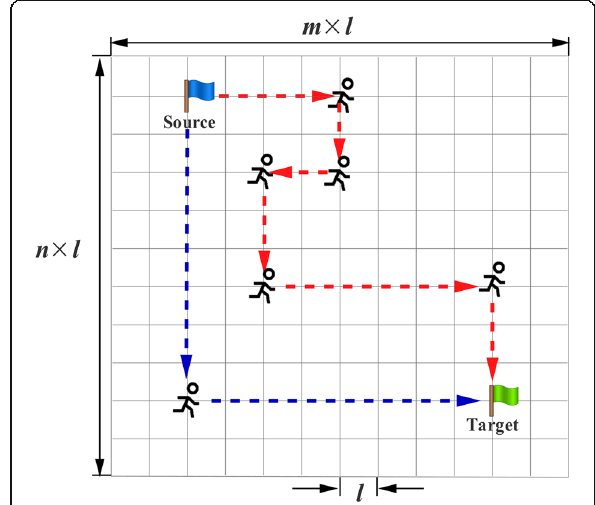
Fig. 1 The grid network with scale m × n , where the walker can move only along its